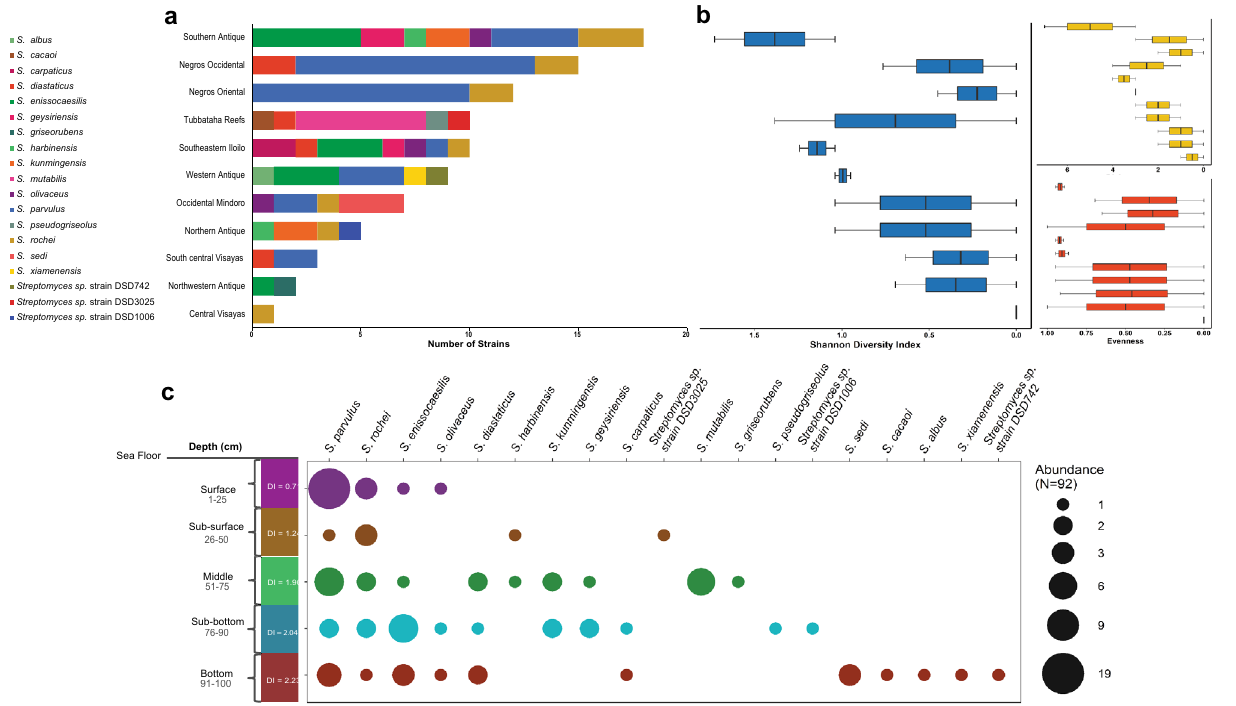
Figure 6. ( a ) The abundance profile of 19 antibiotic-producing Streptomyces species in different geographical location across the Philippines revealed that S. parvulus was the most abundant species. ( b ) Diversity, richness and evenness of antibiotic-producing Streptomyces species in different sites were calculated using vegan package in RStudio ver1.2.5042 (https:// www. rstud io. com/). ( c ) Recovery profile and abundance of antibiotic-producing strain per depth layer, indicated by colored circles and its size, revealed that strains in the bottom sediments were the most diverse as compared to other depth layer and S. parvulus was the most abundant species